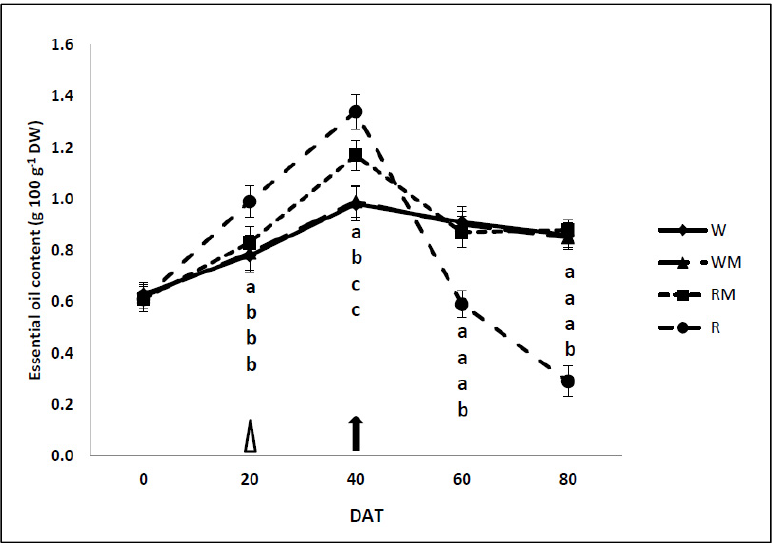
Figure 7. Changes in essential-oil content (g 100 g − 1 d.w.) of spearmint exposed to the following treatments: R—rainfed without straw mulch, RM—rainfed with straw mulch, W—well-watered control plants and WM—well-watered with straw mulch. Measurements were performed 0, 20, 40, 60 and 80 days after the onset of the treatments (DAT). Vertical bars represent ± SE of the mean ( n = 3). Bars with different letters indicate significant differences among treatments in the given DAT at p ≤ 0.05. Triangle at 20 DAT indicates the early bloom, and arrow at 40 DAT indicates the full bloom, in overall